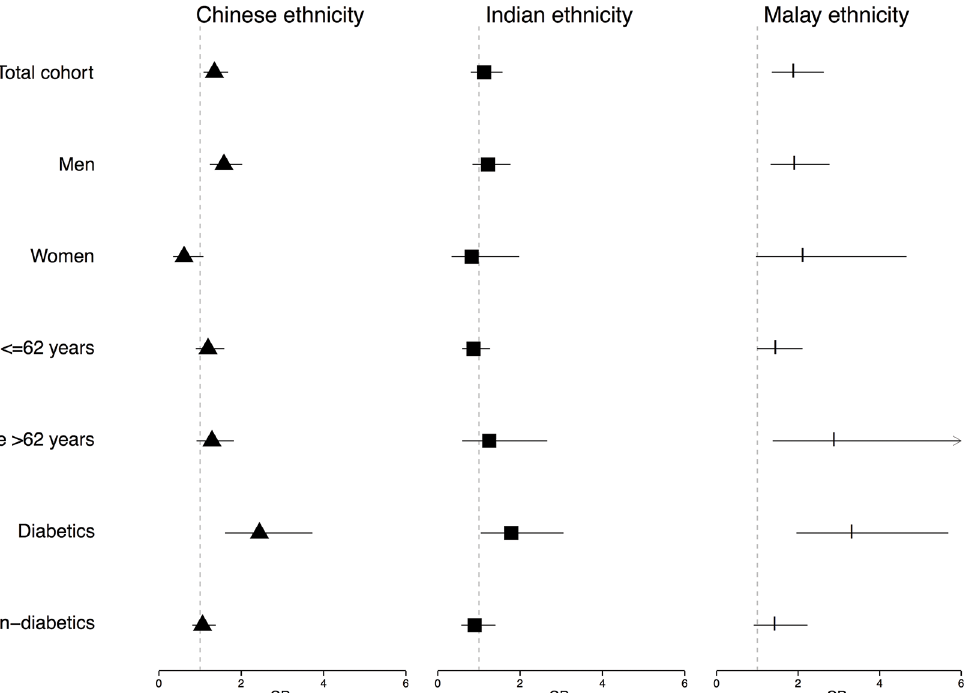
Fig 3. The adjusted odds ratios of Chinese, Indian and Malay ethnicity for the severity of CAD in subgroups of the UNICORN cohort. The adjusted association (odds ratios plus confidence intervals) of Chinese, Indian and Malay ethnicity as compared to White ethnicity for CAD severity, depicted for the total cohort and subgroups of the UNICORN cohort. The displayed odds ratios are derived from a multivariable model containing: age, gender, diabetes, hypertension, dyslipidemia, smoking, BMI, prior acute coronary syndrome, indication for coronary angiogram and use of anti-platelet medication, statins, beta-blocker and RAAS